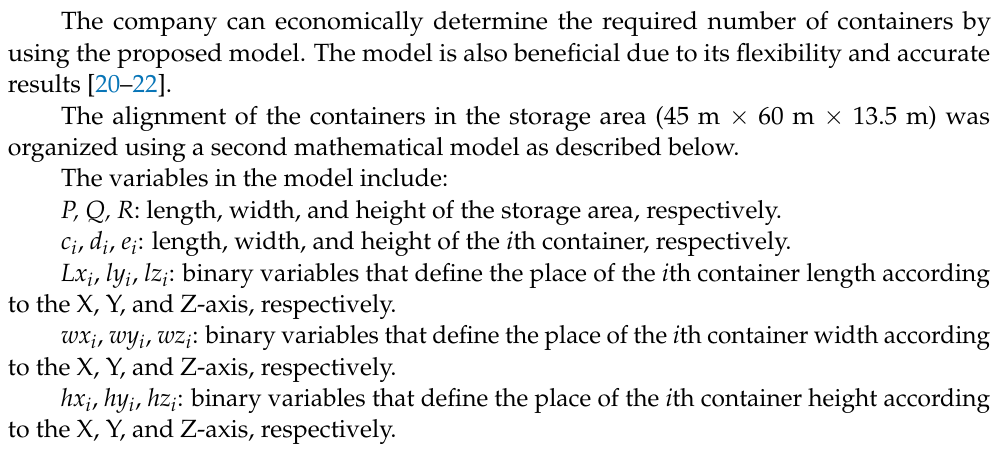
Table 3. The solution of the mathematical model for optimum container types. Total Weight Preferred Number of Type of Pipe Cost ($) (Tons) Container Type Containers 1 1300 20 ft. 65 227,500 2 1500 20 ft. 75 262,500 Total Cost